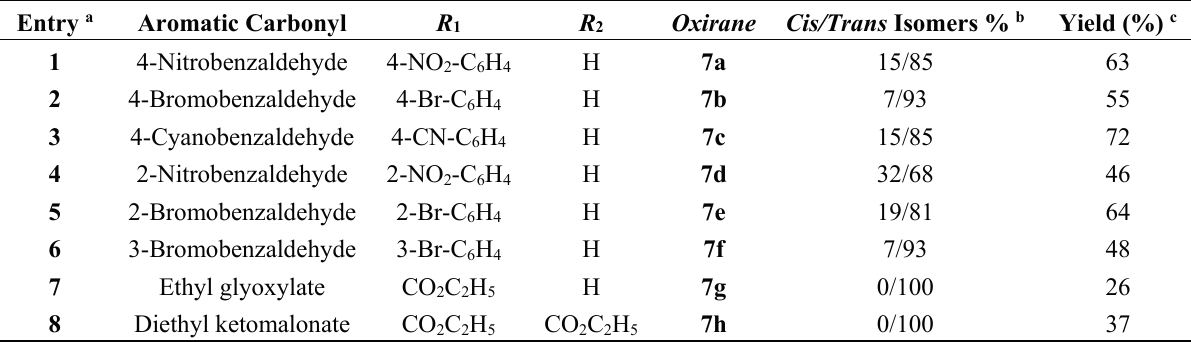
Table 2. Reaction of dibromide 3 with aromatic carbonyl and α -carbonyl ester derivatives using TDAE a